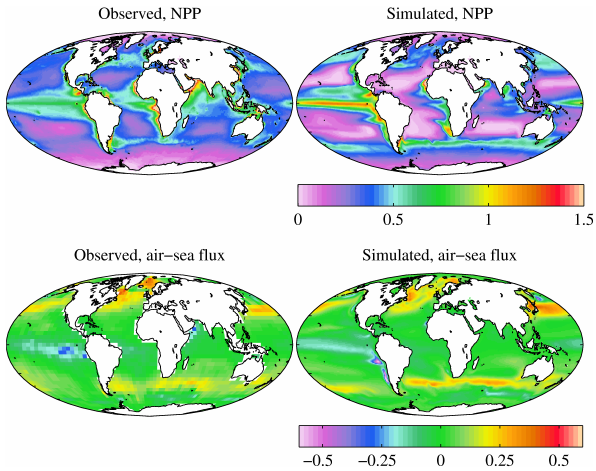
Fig. 7. Observational (left) and simulated (right) annual average Fig.6. Observational( left )andsimulated( right )annualaverageprimaryproduction( top )andair–seaflux( bottom ). ObservationalprimaryproductionhereisingCm − 2 d − 1 andisanaverageoftheVGPM,Eppley–VGPMandCbPM primary production (top) and air–sea flux (bottom). Observational estimates. Observationalair–seafluxisinppmandistakenfromTakahashietal.(2009). primary production here is in gCm − 2 d − 1 and is an average of the VGPM, Eppley-VGPM and CbPM estimates. Observational air–sea flux is in molCm − 2 month − 1 and is taken from Takahashi et al. (2009).